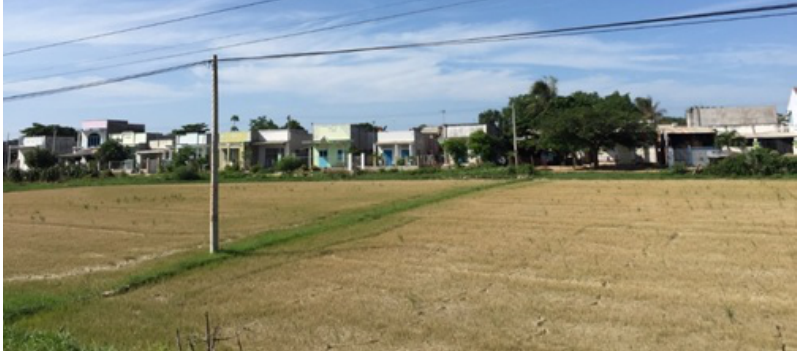
Figure 9. Lack of fresh water for irrigation created these desiccated lands in the commune of Phuoc